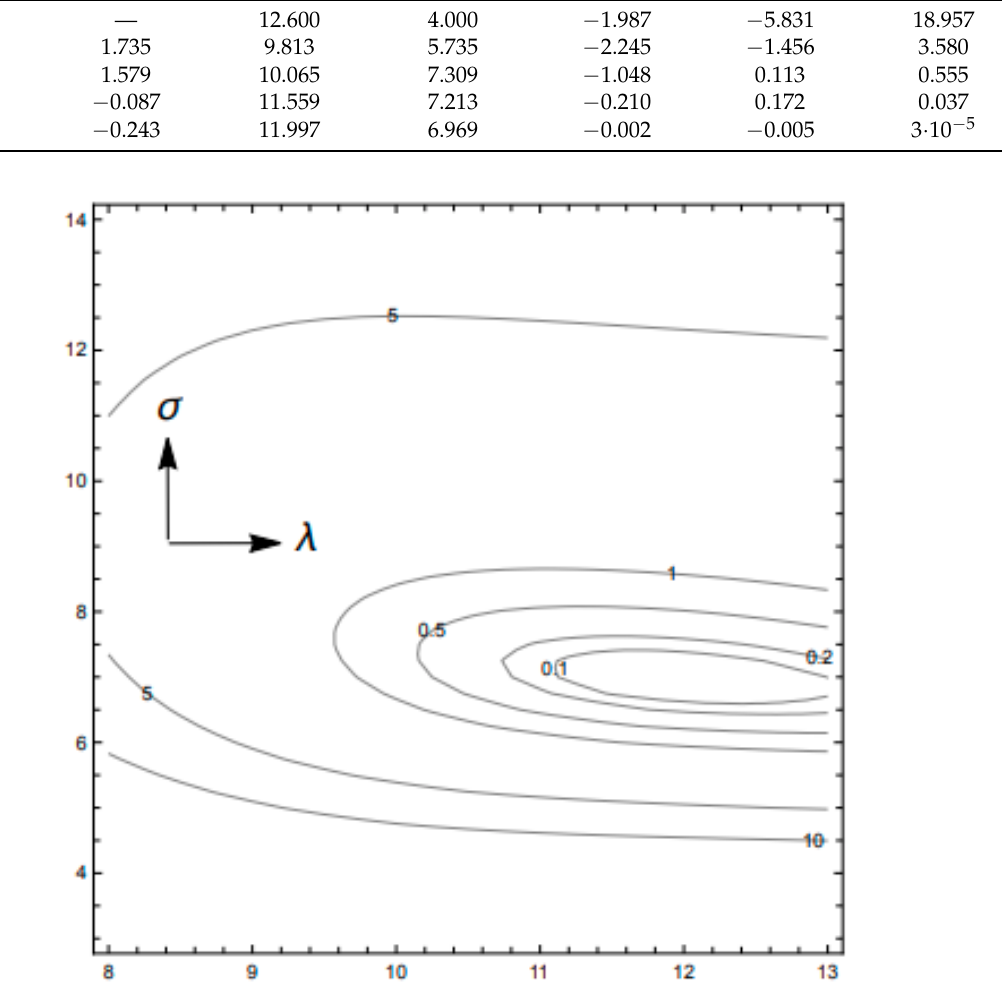
Table 2. FSM Iterates for λ .